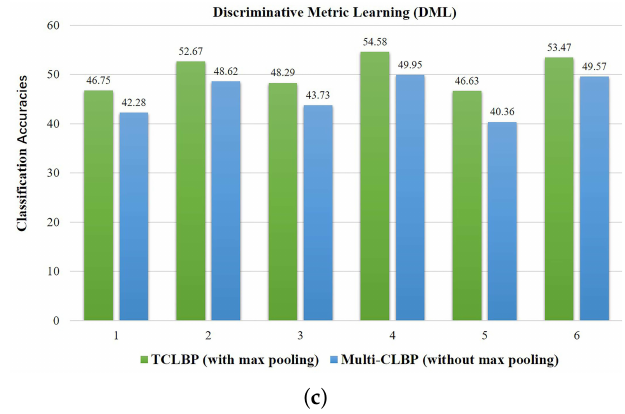
Figure 10. ( a – c ) We implement 6 cross-domain classification experiments with different metrics. The Arabic numbers in abscissa denote the domain shifts of CAMS to IAP, CAMS to MOC, IAP to CAMS, IAP to MOC, MOC to CAMS, MOC to IAP, respectively.